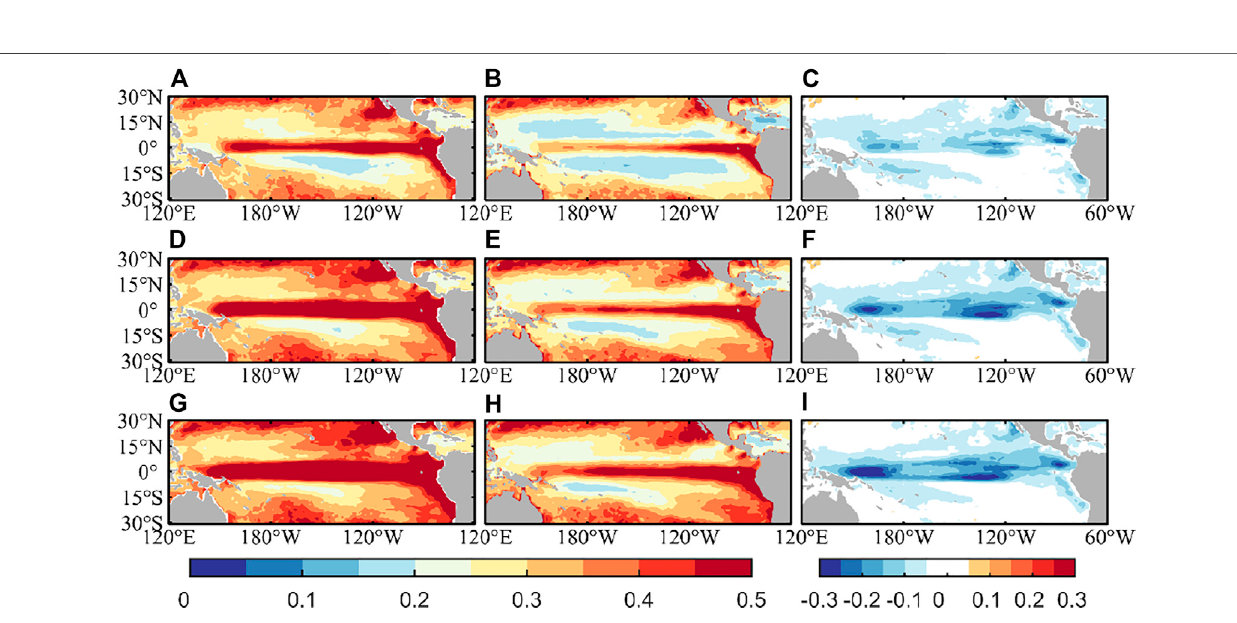
FIGURE7| Spatialdistributionoftheabsolute averageerror(AAE,units: ° C) ofthe SSTAbetweenthepredictions and OISST v2.1, (A,D, G) FIO-CPS v1.0 results, (B, E, H) FIO-CPS v2.0 results, and (C, F, I) the difference between FIO-CPS v2.0 and FIO-CPS v1.0. (A – C) 2-month lead time, (D – F) 4-month lead time, and (G – I) 6- month lead